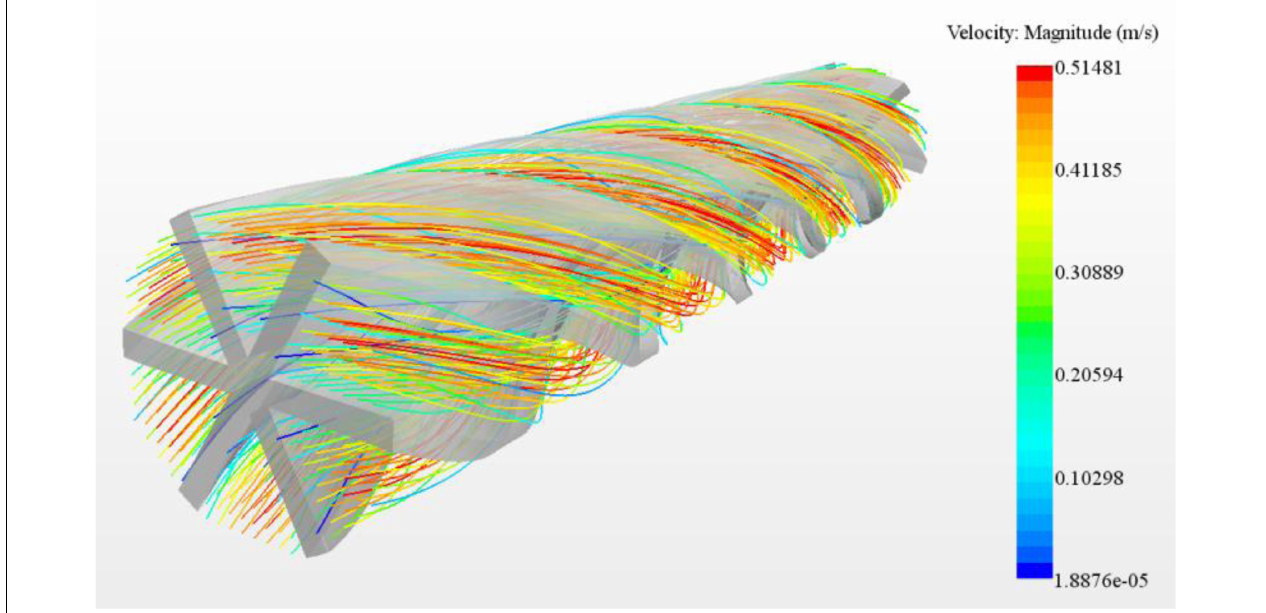
FIGURE 2 | The streamline of the tube fitted with CCTTT ( y = 3) at l = 0.24 m, Re = 720.